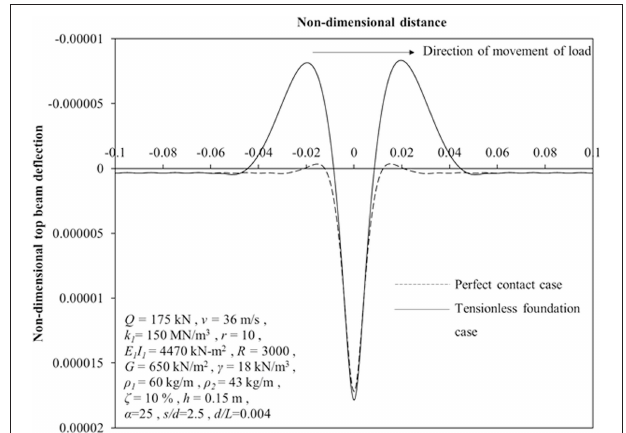
FIGURE 5 | Deflection of top beam for perfect contact case and tensionless foundation case.